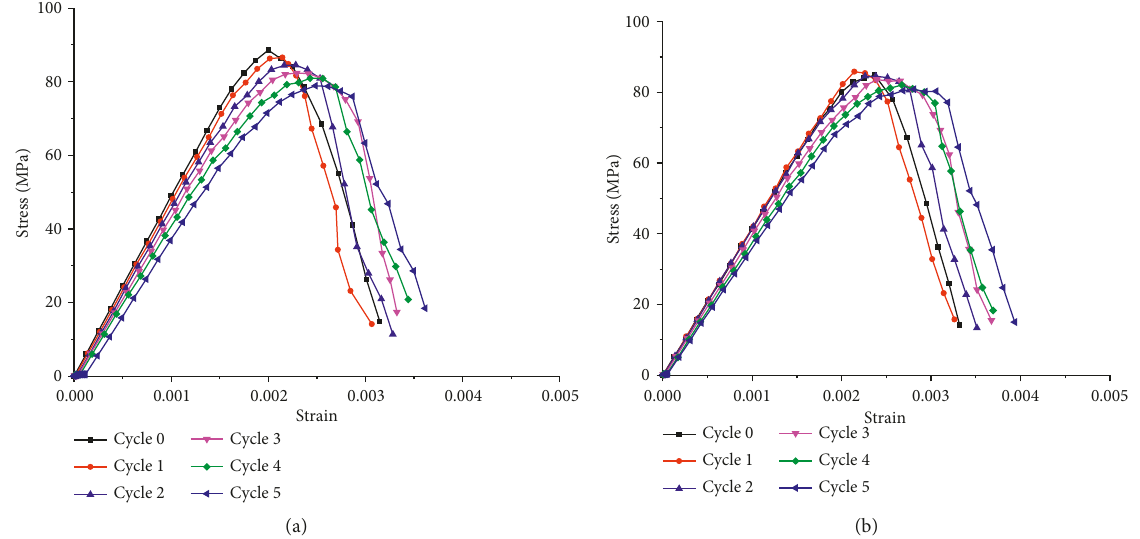
Figure 5: Stress-strain curves of C100 concrete. (a) Internal environment. (b) External